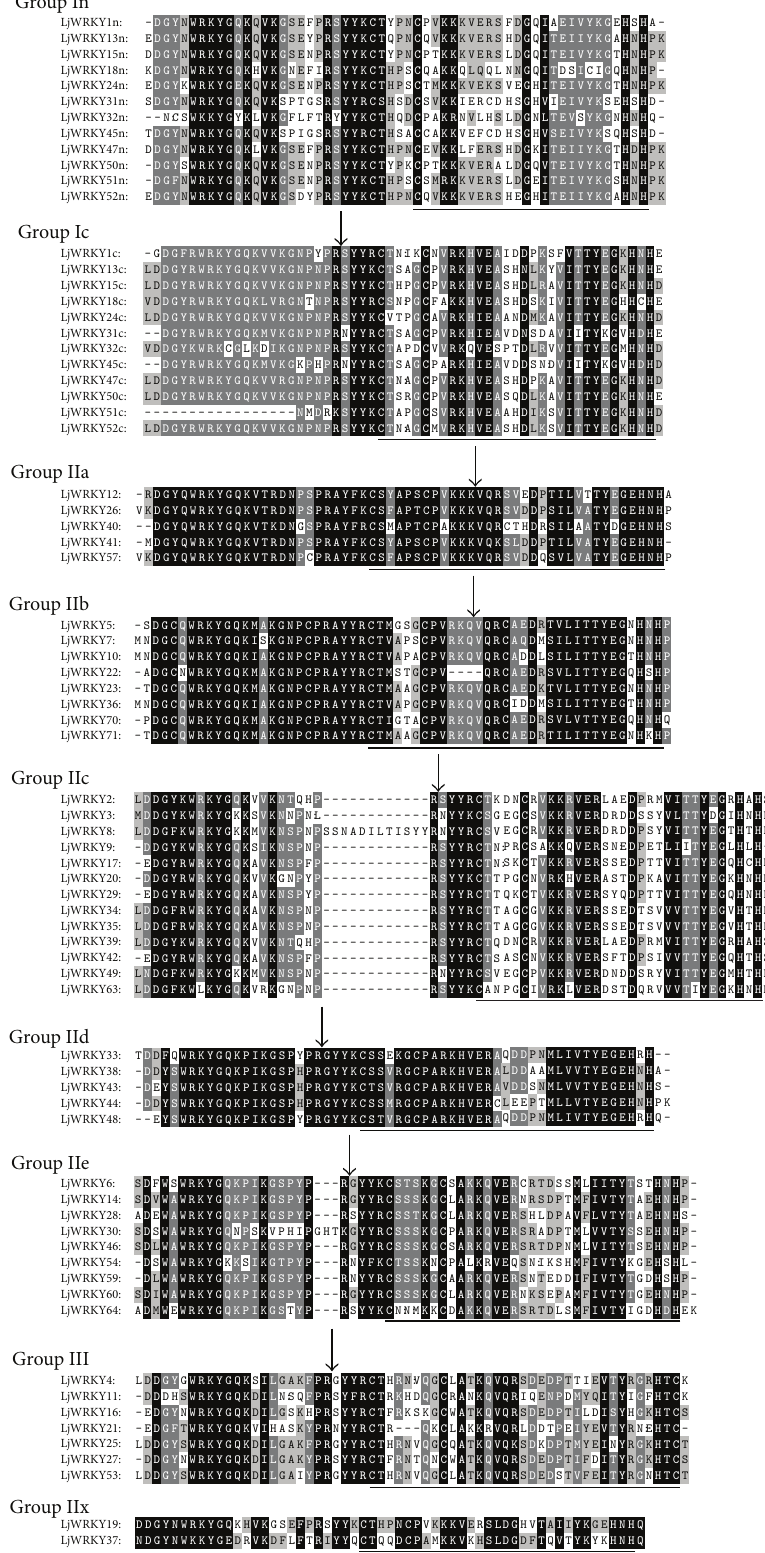
Figure 3: Amino acid residue alignment of Lotus japonicus WRKY domain. Alignment was performed using the Clustal W program and is displayed with the software Gendoc. Residues that were highly conserved within each of the major groups are in black. The position of a conserved intron was indicated by an arrowhead. The black lines indicated the conserved zinc finger